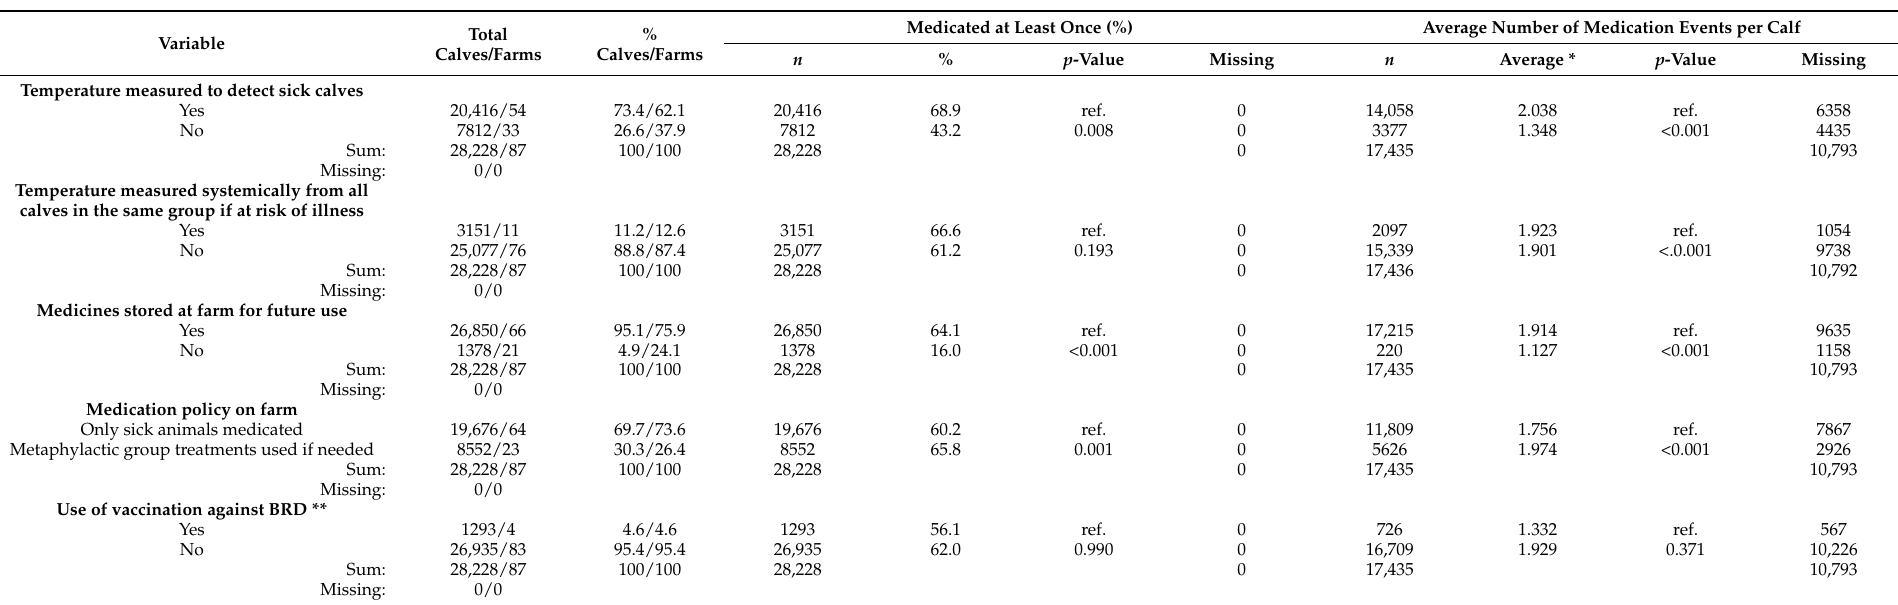
Table 4. Descriptive statistics of medication practices followed in 87 calf rearing farms with 28,228 reared calves and univariate associations of predictor and outcome variables. % Variable Total Calves/Farms Calves/Farms